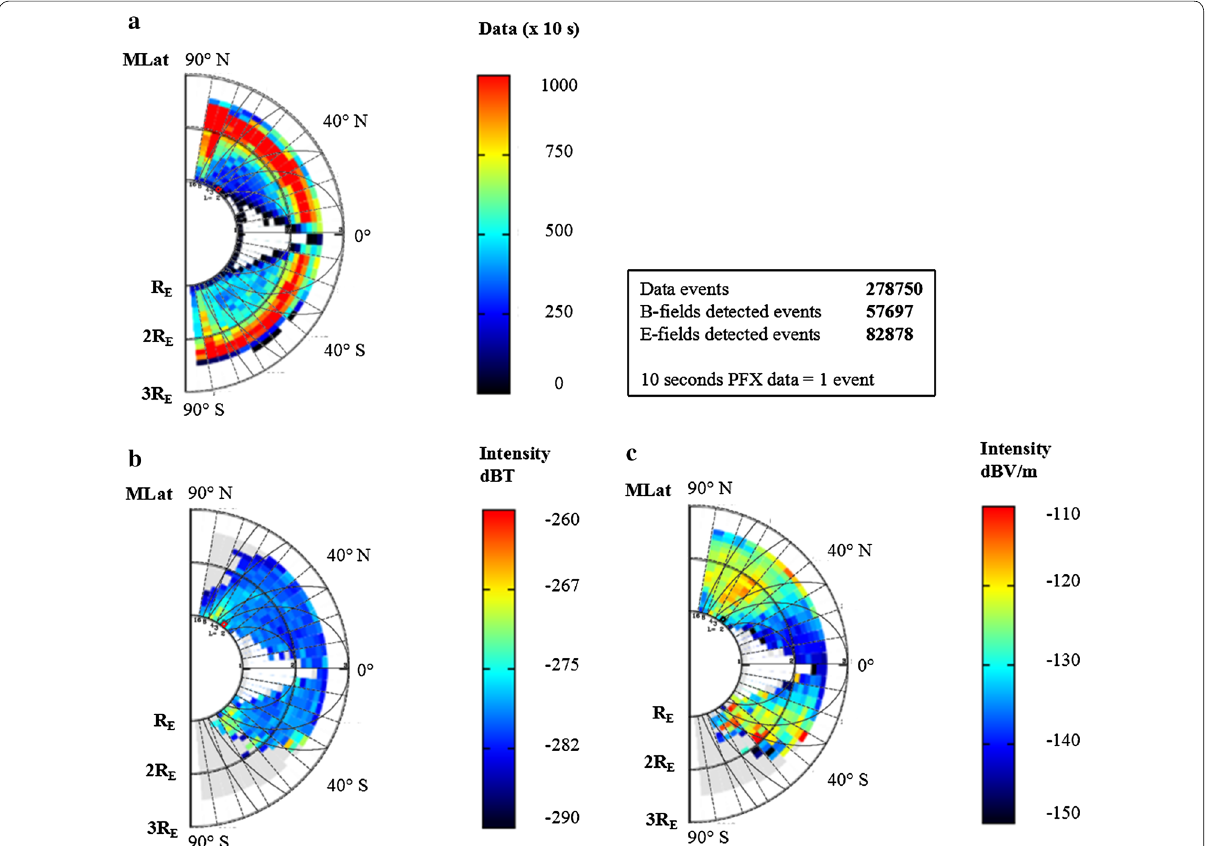
Fig. 3 a Duration of data processed in the magnetic and electric field with longitude restricted to way station in the magnetic field and c the electric field. Rectangle indicates the location of the Norway station at latitude 55.96° N and longitude 100.72°